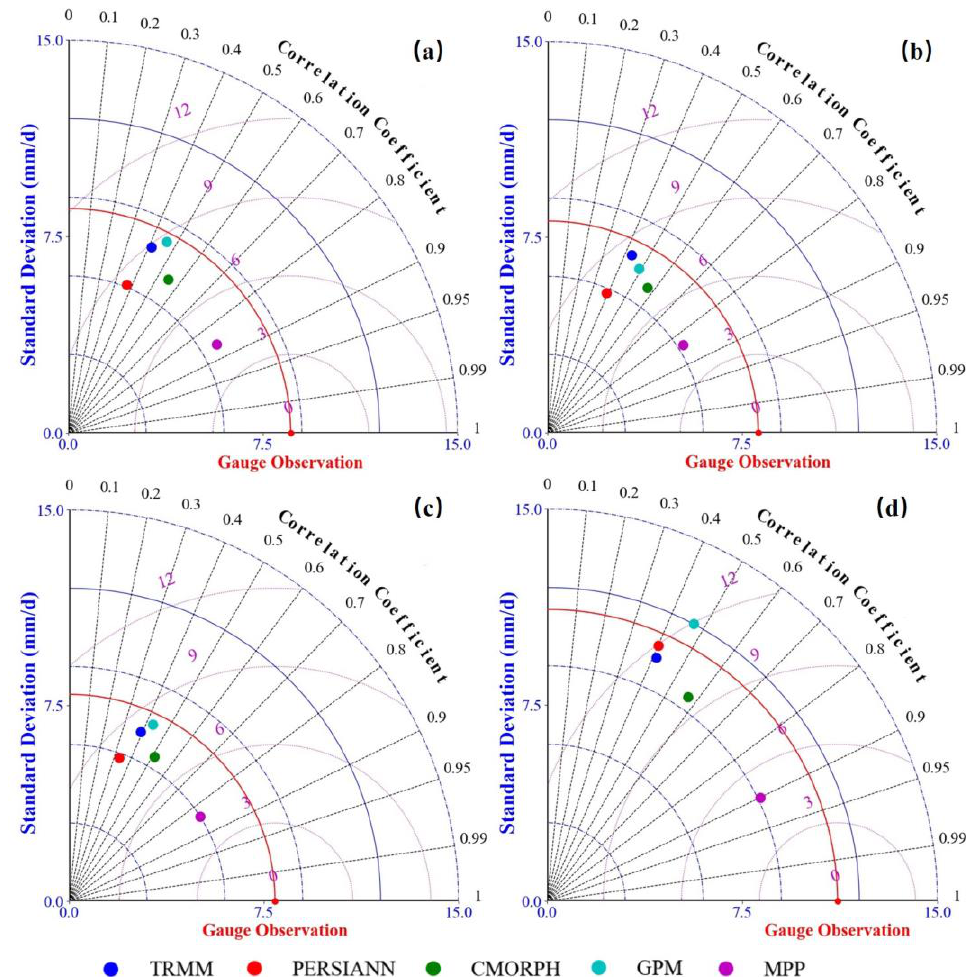
Figure 9. Taylor diagrams of daily precipitation from the final MPP, the original SPPs (i.e., TRMM, CMORPH, PERSIANN, and GPM), and gauge observations across ( a ) the whole basin, ( b ) the upper reaches, ( c ) the middle reaches, and ( d ) the lower reaches.